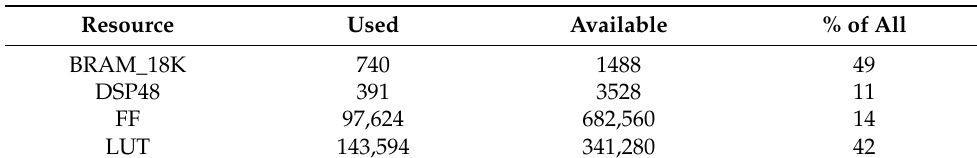
Table 3. FPGA resource requirements.